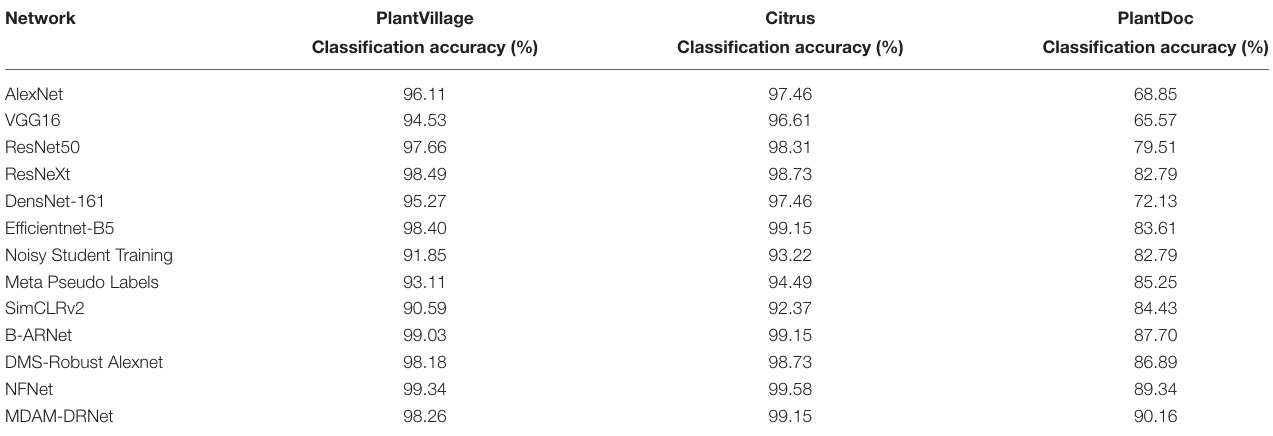
TABLE 11 | Recognition accuracy of 13 models tested on three public data sets.